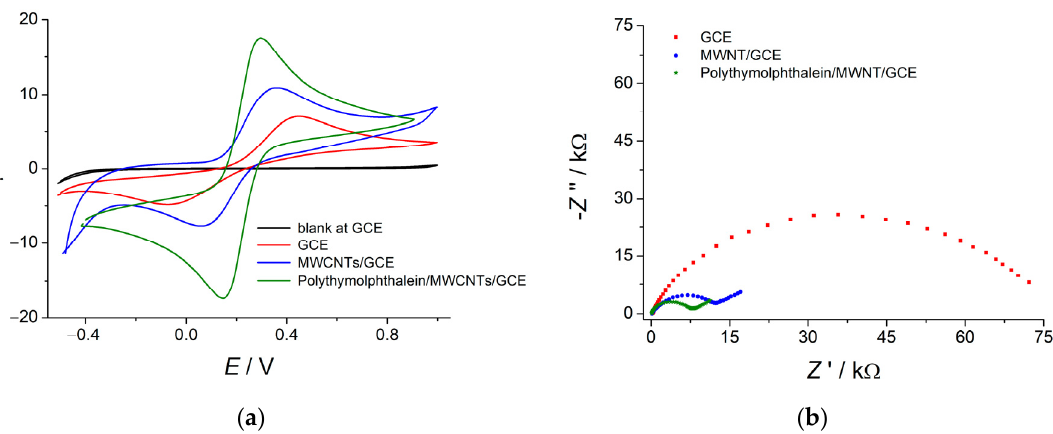
Figure 5. ( a ) CVs of 1.0 mM ferrocyanide ions in 0.1 M KCl at the bare GCE, MWCNTs/GCE and polythymolphthalein/MWCNTs/GCE ( υ = 100 mV s ‒ 1 ); ( b ) nyquist plot for bare GCE, MWCNTs/GCE and polythymolphthalein/MWCNTs/GCE in the presence of 1.0 mM ferri-/ferrocy- anide ions in 0.1 mol L − 1 KCl. E = 0.23 V; frequency range is 10 kHz–0.04 Hz; amplitude is 5 mV. Table 1. Electroactive surface area and fi tt ed electrochemical impedance parameters of the elec- trodes ( n = 5; p = 0.95). Table 1. Electroactive surface area and fitted electrochemical impedance parameters of the electrodes ( n = 5; p =